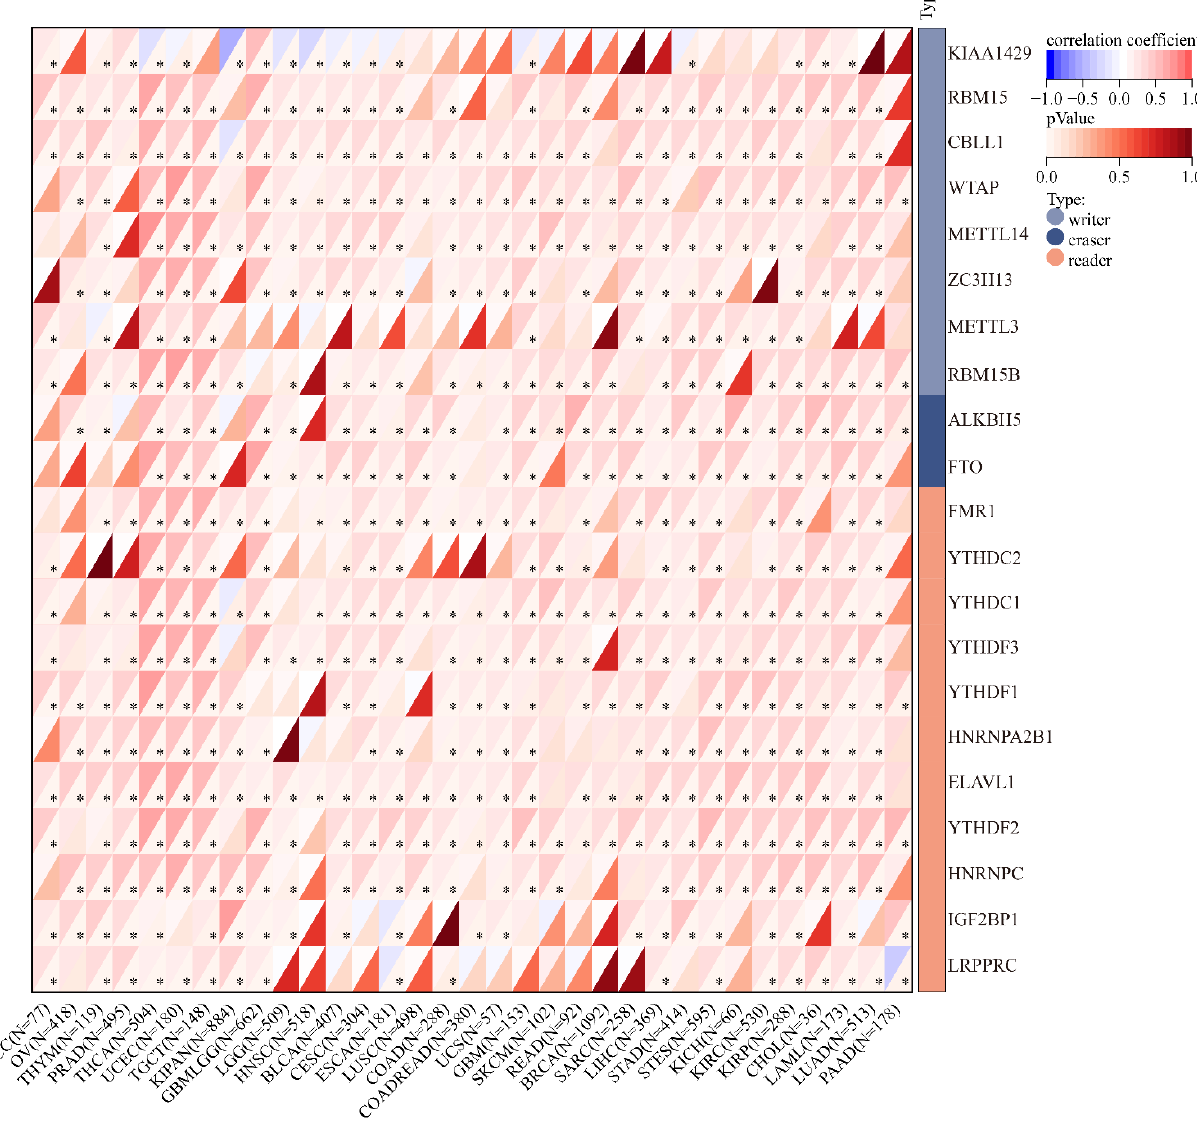
Figure 10. Relationship between SLC2A1 expression and RNA m6A-methylation-related genes in pan-cancer (*, p < 0.05).